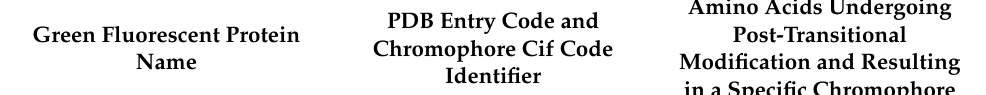
Table 1. New generation of commonly used GFPs for pH sensing. The entries are retrieved from the Protein Data Bank [122]. Identifiers of chromophore and harboring three-amino acids are indicated. The 3D structure for each entry and other protein annotations can be explored from the following link and searching for the indicated PDB code. Related entries can be retrieved from the structure summary page of each entry. Link: https://www.rcsb.org, accessed on 31 March